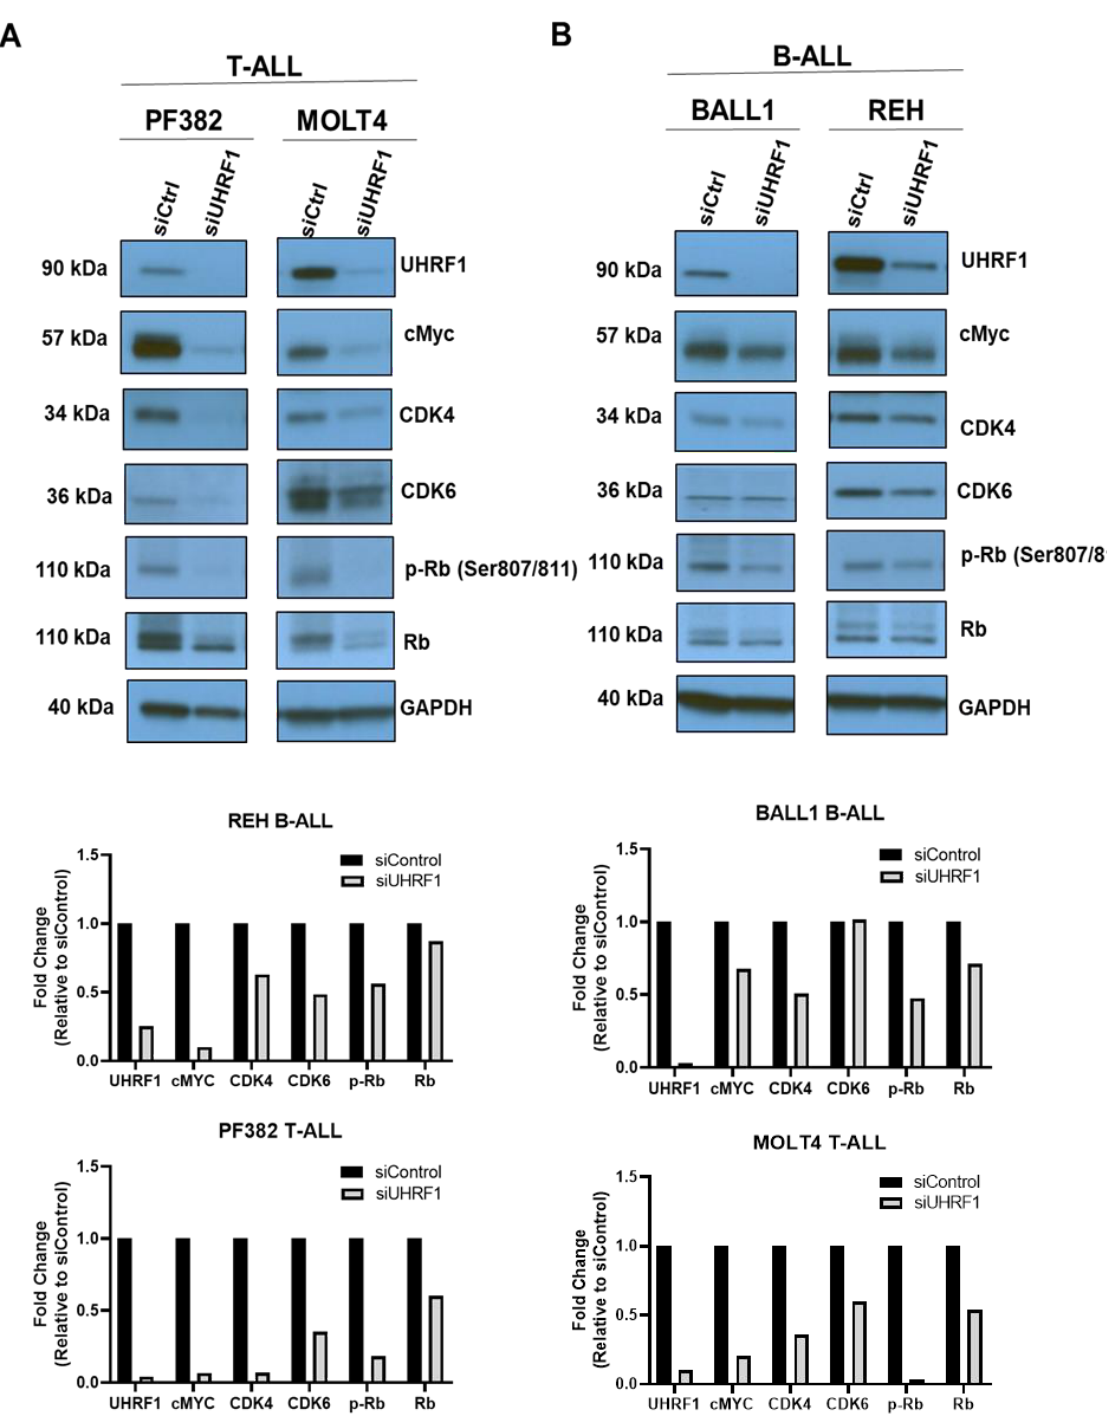
Figure 3. Regulation of the c-Myc-CDK4/6-phosphoRb axis by UHRF1 in B-ALL and T-ALL. A knockdown of UHRF1 led to reduced c-Myc protein in ( A ) T-ALL and ( B ) B-ALL cells. The ALL cells were transfected with siRNA-targeting UHRF1 and a control siRNA. After being incubated for 48 h, the UHRF1, c-Myc, CDK4/6, and p-RB/RB protein levels were analyzed using Western blot and densitometry. The uncropped blots are shown in Figure